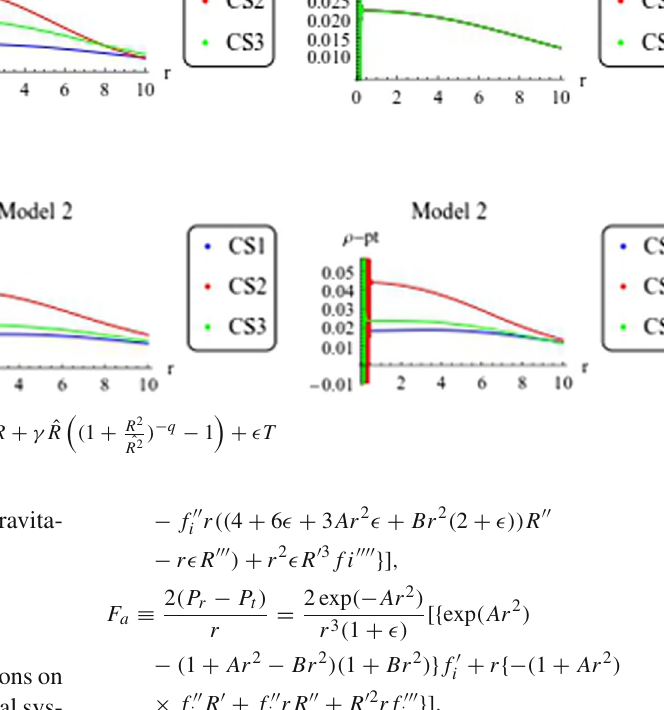
(cid:5) (cid:6) ( 1 + R 2 ) − q − 1 + (cid:17) ˆ R 2